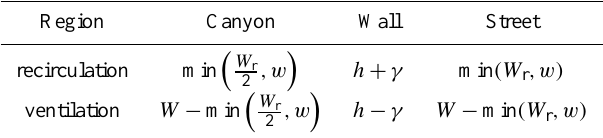
Table 1. Different widths/heights of urban surfaces depending on the canyon geometry. Region Canyon Wall Street